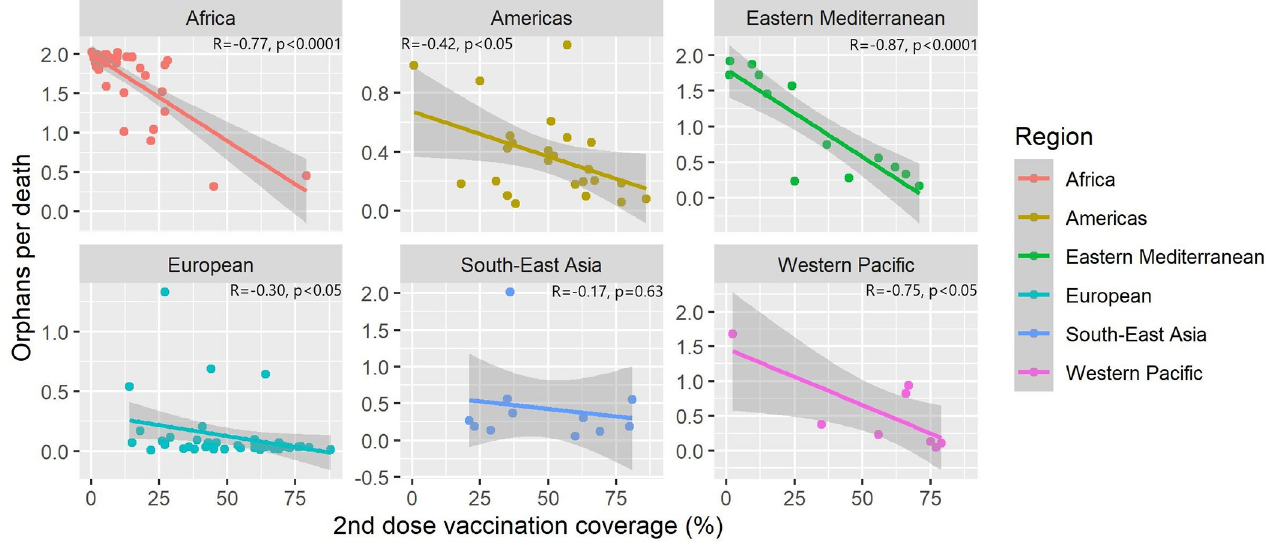
Fig 5. Association between 2 nd dose vaccination coverage and OPD by region. Correlation coefficient and p-value for univariate linear regression models displayed in text in main panels. Gray bands represent 95% confidence intervals. Vaccination data as of 1 st December 2021.